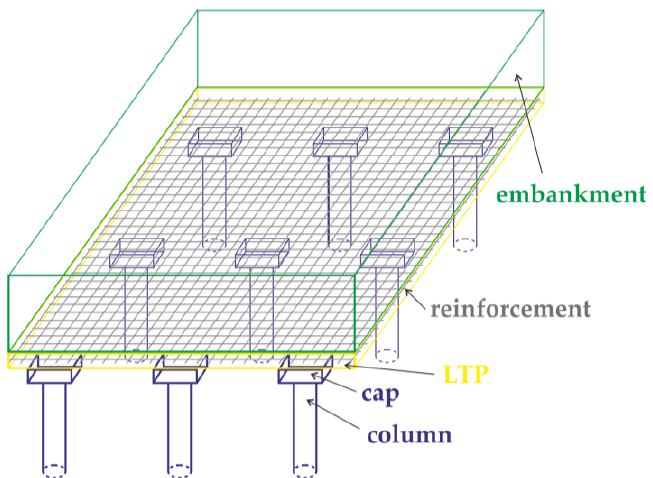
Figure 1. Basal reinforced piled embankment—arrangement of layers.